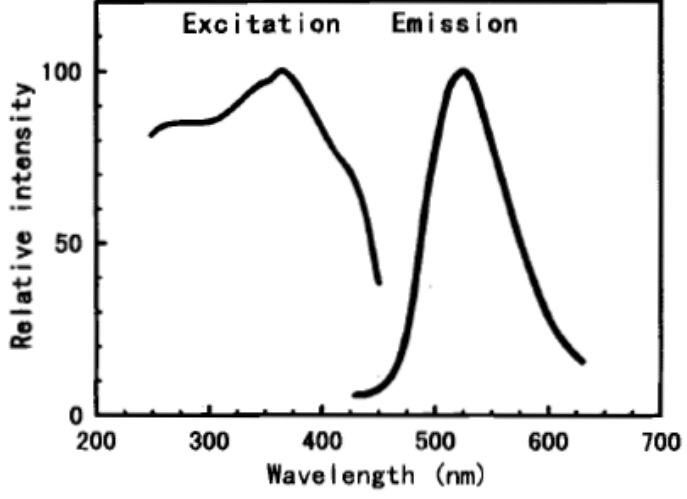
Figure 3. Excitation and emission spectra of SrAl permission from [5]. Copyright 1996, The Electrochemical Society)